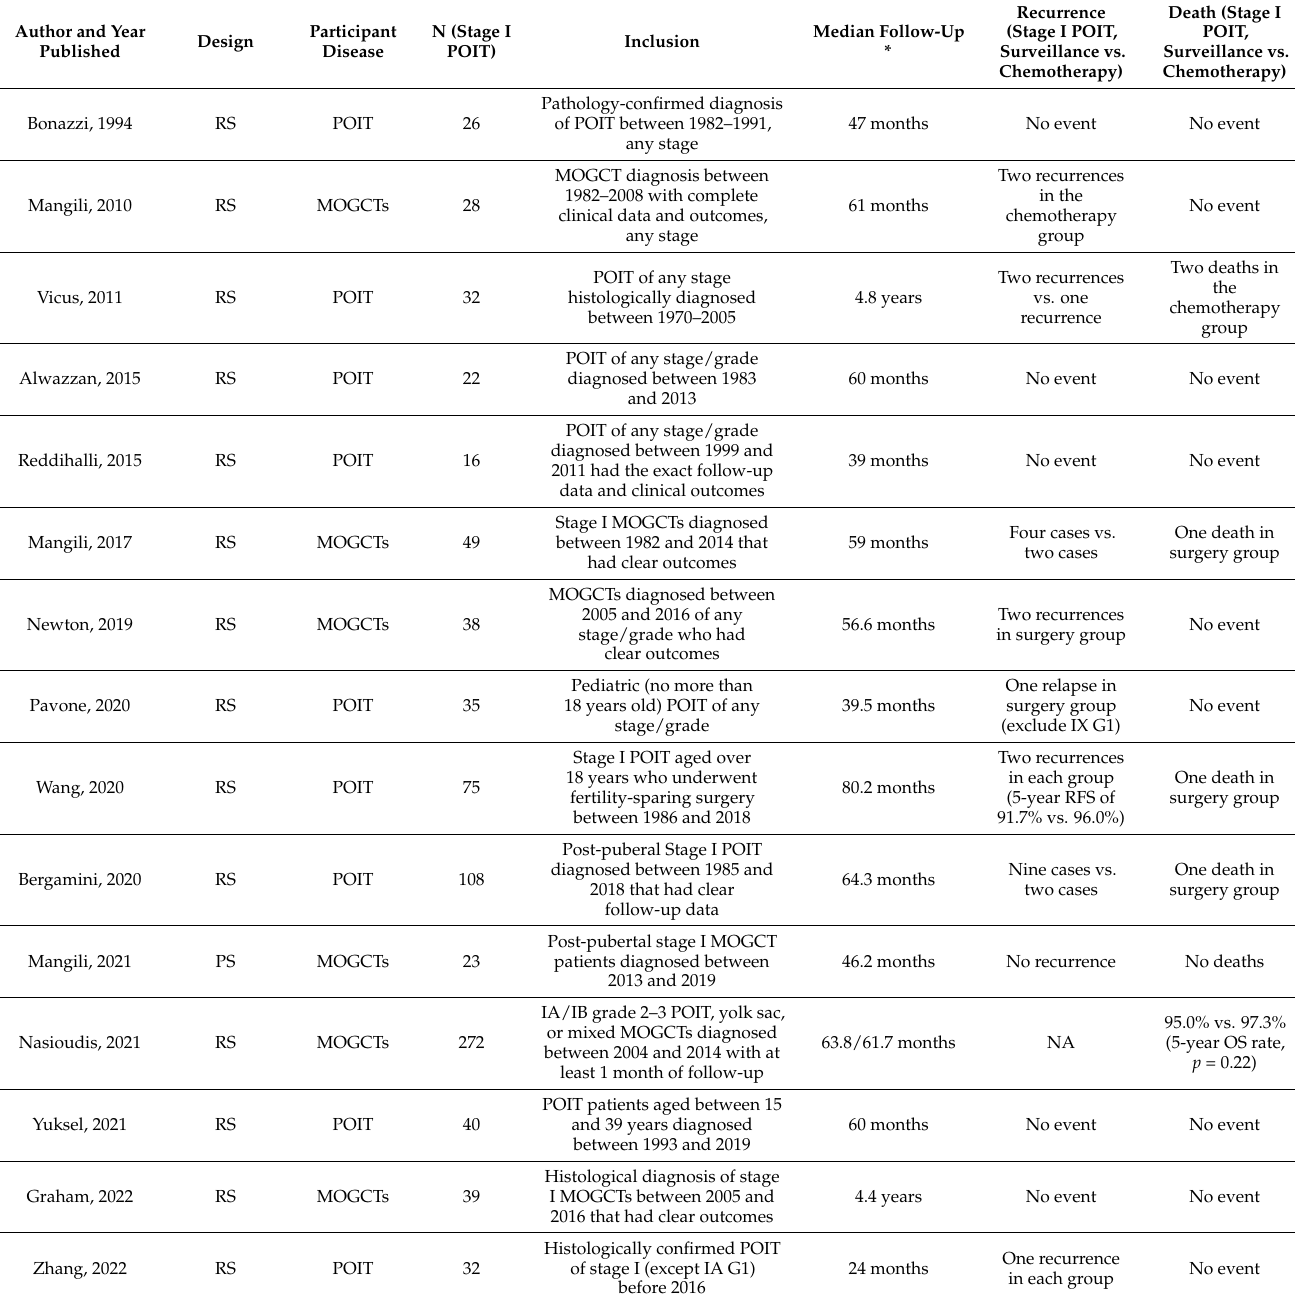
Table 1. The clinical characteristics of the included studies in our